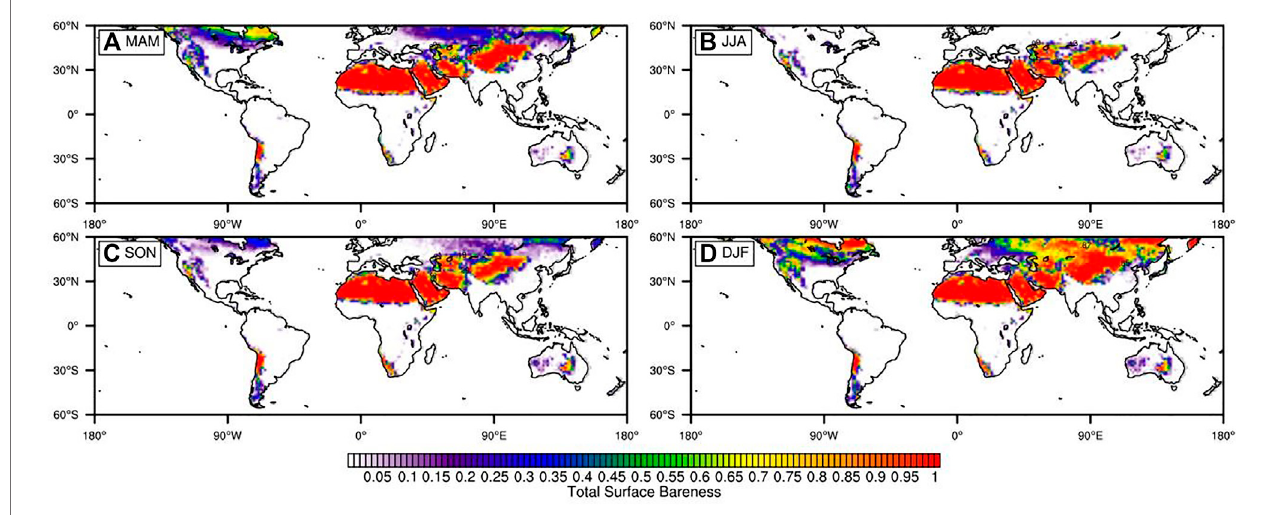
FIGURE1| Seasonalvariationsintotalsurfacebarenessattheglobalscaleduring2001 – 2018. (A) MAM:March,AprilandMay; (B) JJA:June,JulyandAugust; (C) SON: September, October and November; (D) DJF: December, January and February (same below).